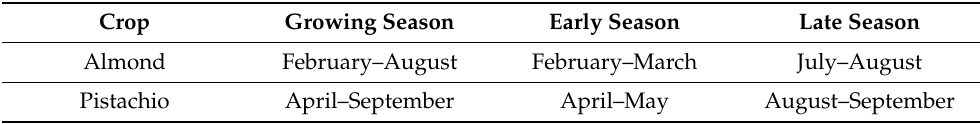
Table 3. Growing seasons in the San Joaquin Valley for almond and